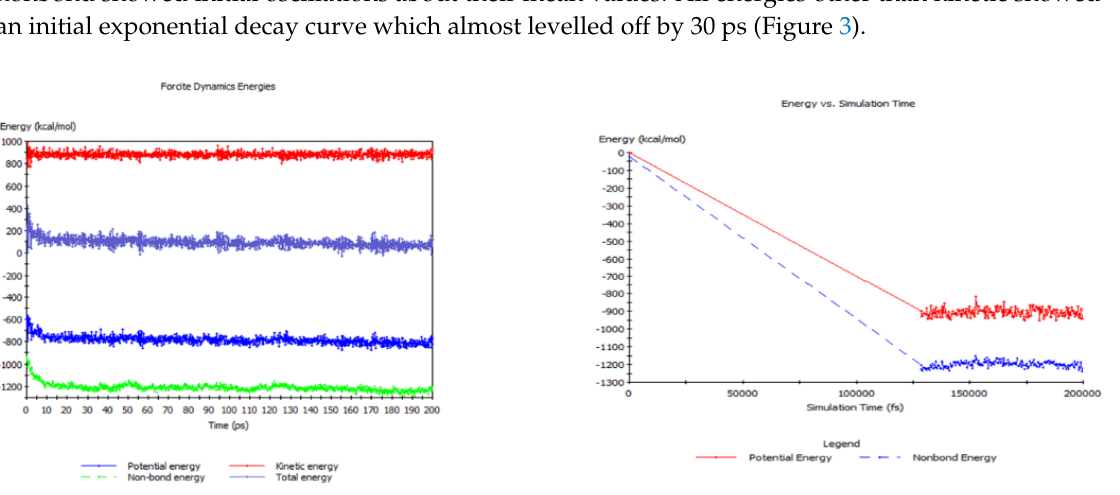
Figure 3. Convergence of energies in the model under conventional molecular dynamics simulation. Figure 2A (left) and 2B (right): Variation in energy across a 200 ps RMD simulation of the 1000 atom, 100% cured phenol-formaldehyde resin (PFR) model generated by Forcite (Left) and Discover (Right).